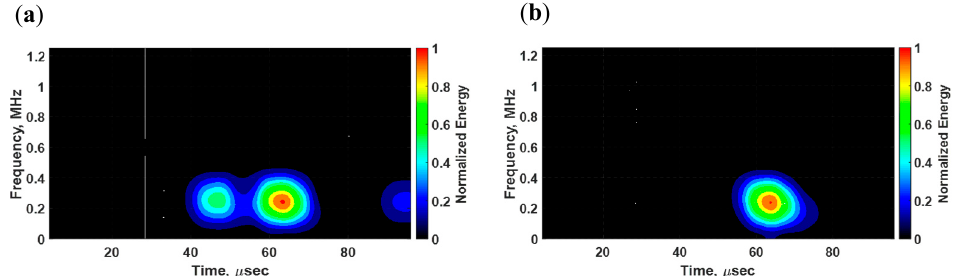
Figure 18. Time-frequency spectrums of voltage signals obtained from a ( a ) d31 PZT sensor and ( b ) d35 PZT sensor for a laminate structure with a notch excited with a d35 PZT actuator at 250 kHz.